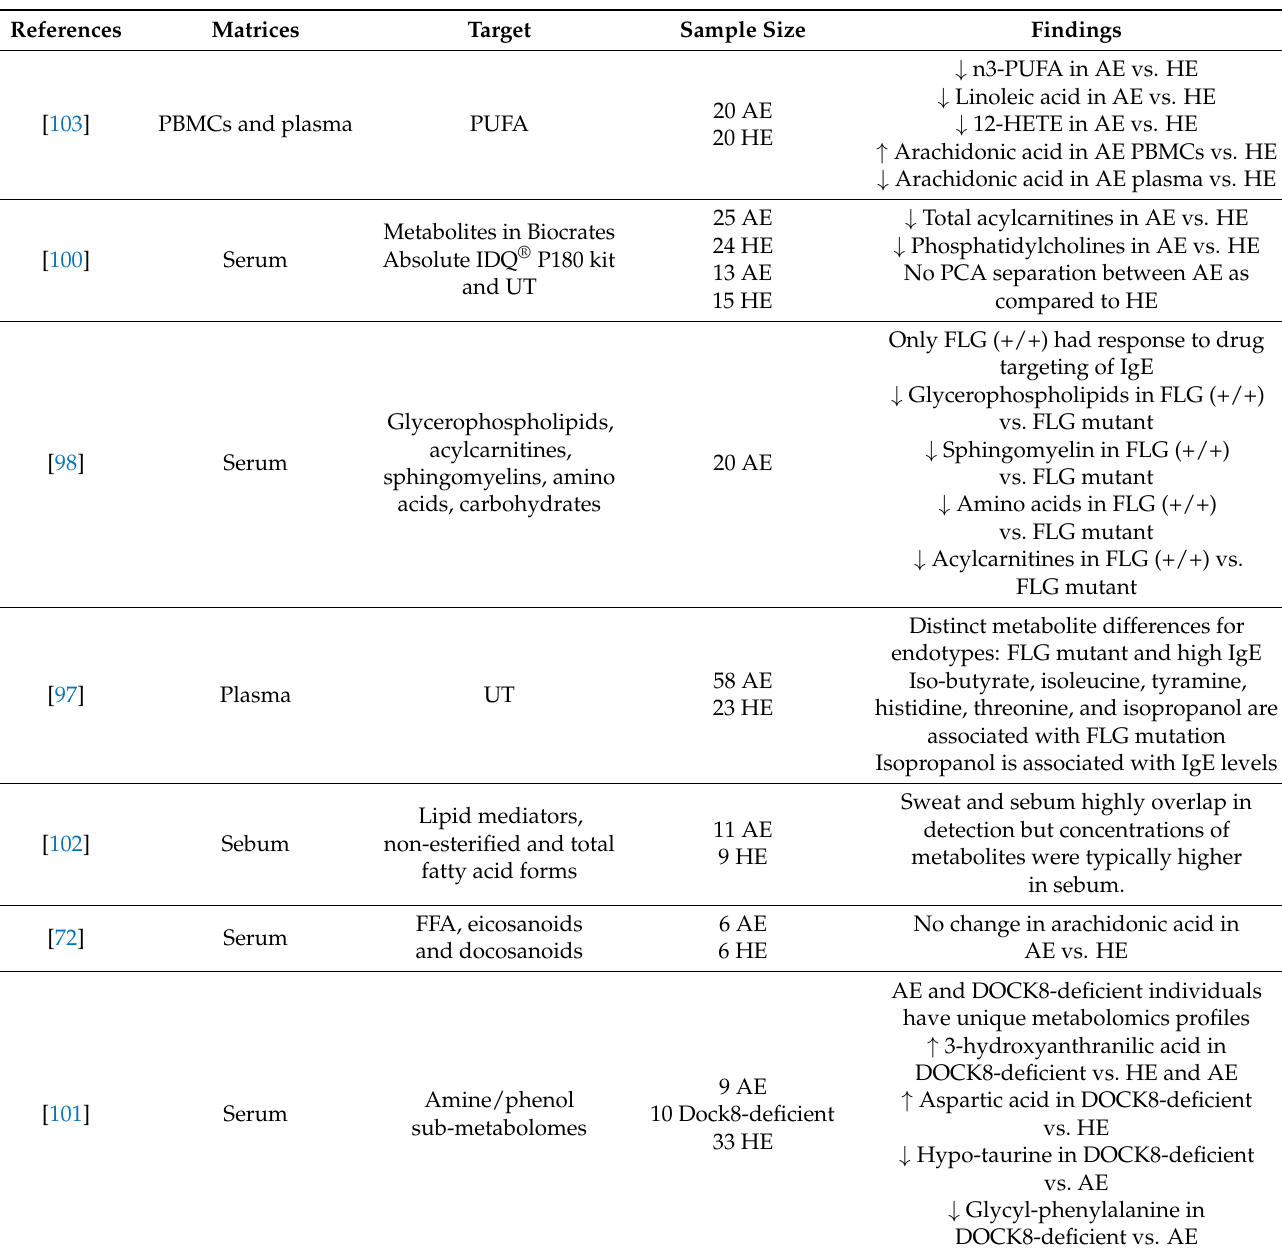
Table 3. Summary of AE metabolomics studies with blood samples. Abbreviations: AE (atopic eczema participants), LS (lesional skin), NL (non-lesional skin), HE (healthy participants), P (psoriasis participants), SCSFAs (short-chain saturated fatty acids), LCSFAs (long-chain saturated fatty acids), FA (fatty acids), ADMA (asymmetric dimethyl-arginine), C (chain length). Co. (cooperation), FLG (filaggrin), FFA (free fatty acids), UT (untargeted), IV (ichthyosis vulgaris), PBMCs (peripheral blood mononuclear cell), PUFA (poly-unsaturated fatty acids), and PCA (principal component analysis). Symbols: ↑ (increase) and ↓